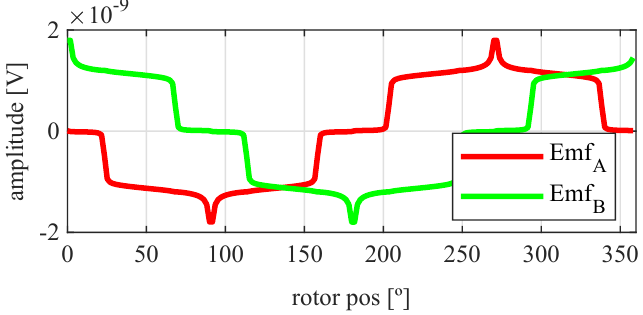
Figure 11. Short pitch four-slot resolver EMFs with the least THD.